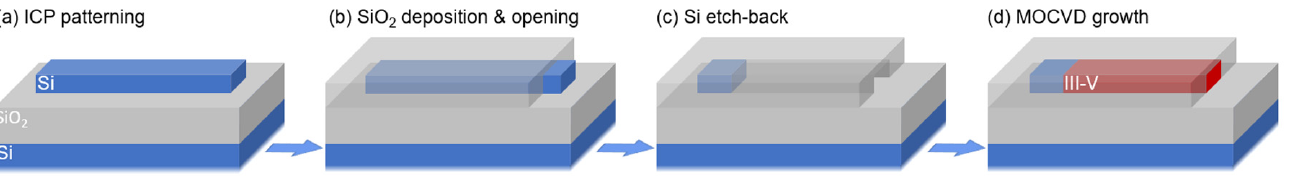
Figure 2. Schematic of TASE process flow. ( a ) Patterning of a SOI wafer by standard lithographic methods and Si patterning processes. ( b ) Deposition of an oxide layer (SiO 2 ) which covers the Si structure. A window is etched into the SiO 2 layer to expose one end of the underlying Si. ( c ) The Si structure is partially etched back using TMAH, leaving a hollow template behind and exposing a small Si nucleation seed at one extremity. ( d ) MOCVD growth of the III-V material into this template, nucleating on the Si seed.